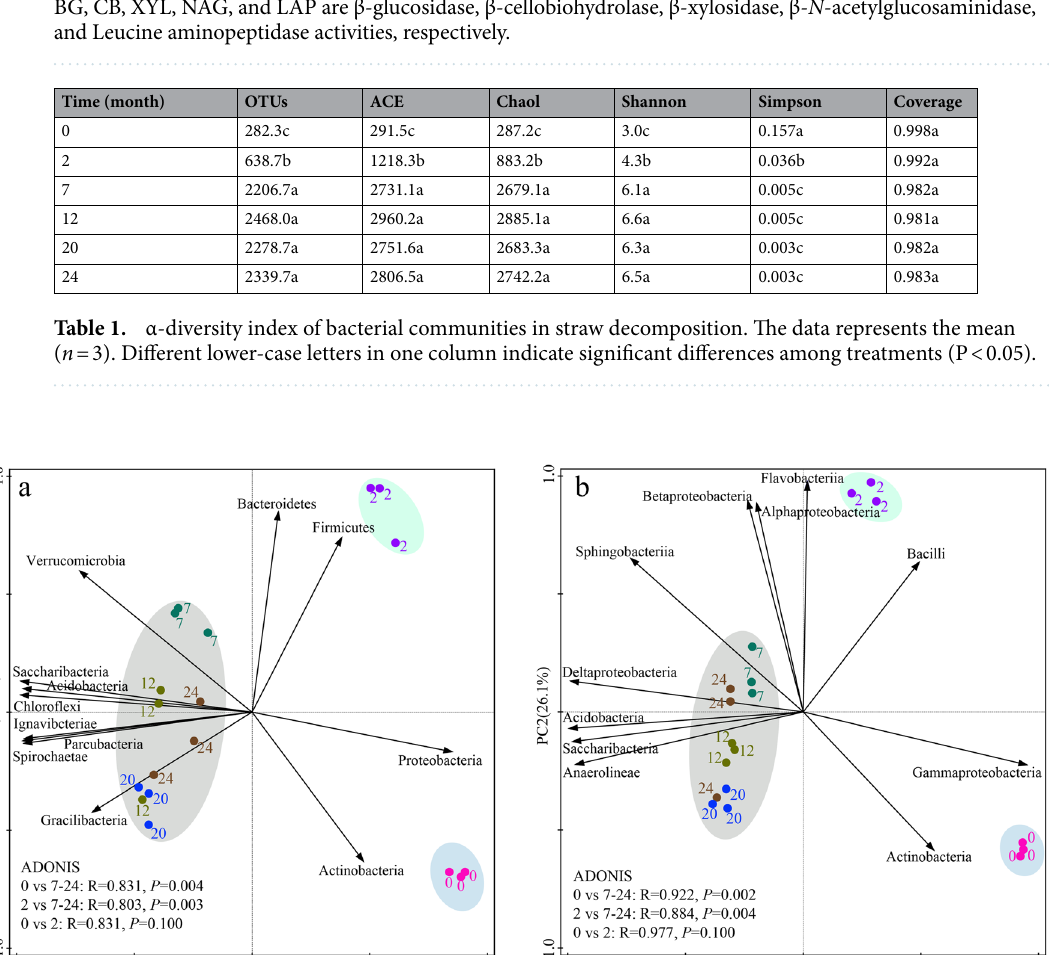
Figure 3. Principal Component analysis of straw bacterial community composition at phylum ( a ) and class ( b ) levels for different months of